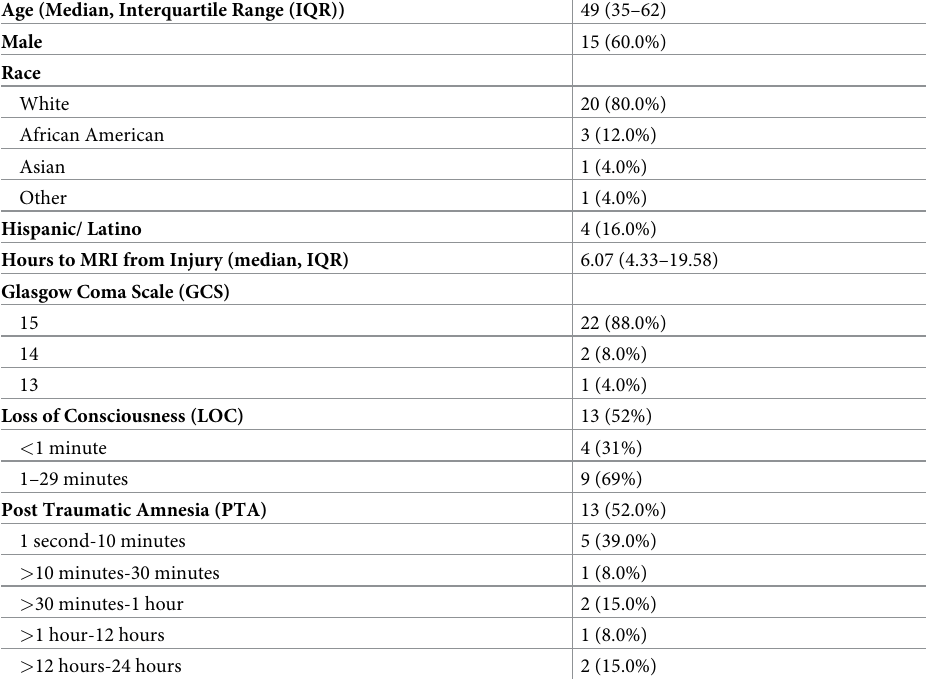
Table 1. Clinical demographic characteristics of study population (N =